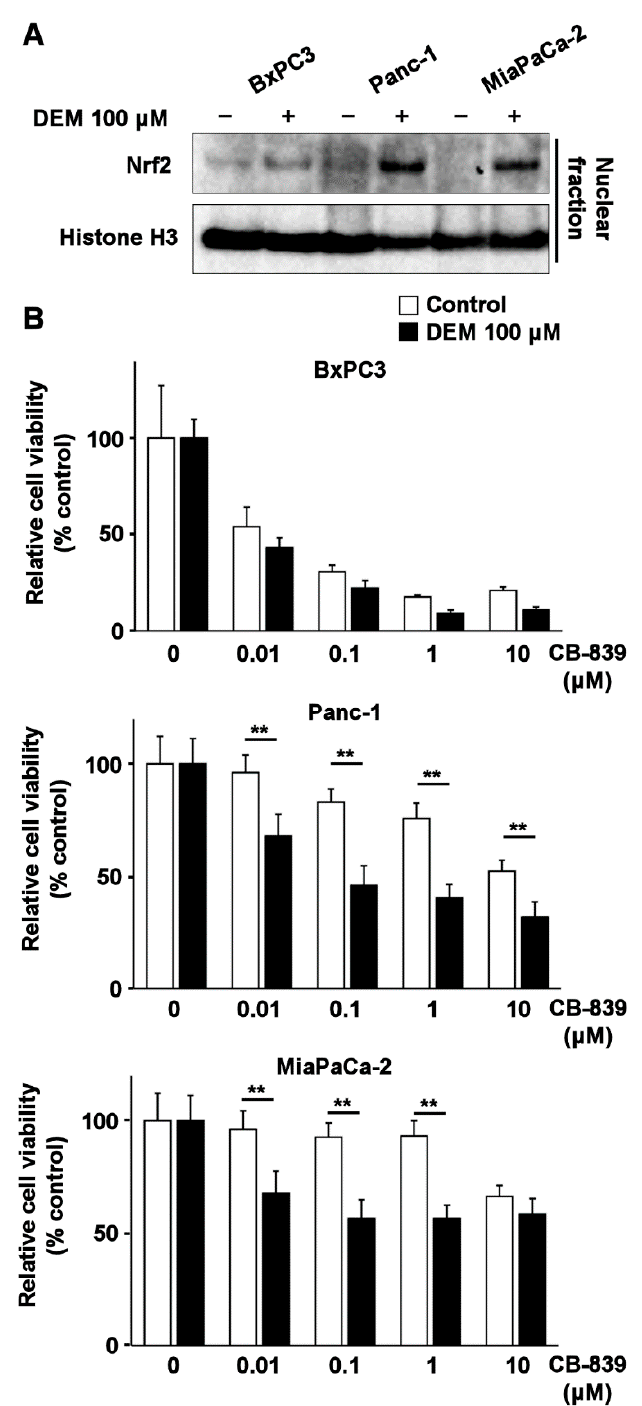
Figure 5. Induction of Nrf2 and sensitization to CB-839 by DEM treatment in human pancreatic cancer cell lines. ( A ) Nuclear accumulation of Nrf2 in BxPC3, Panc-1, and MiaPaCa-2 cells after DEM treatment. Histone H3 is used as the loading control. ( B ) MTT assay for checking the viability of BxPC3, Panc-1 and MiaPaCa-2 after CB-839 treatment ( N = 6, 5000 cells/well, 48 h; with or without DEM pretreatment (100 µ M, 24 h)). ** indicates p < 0.01 by the Tukey–Kramer method. The error bars show standard deviations.